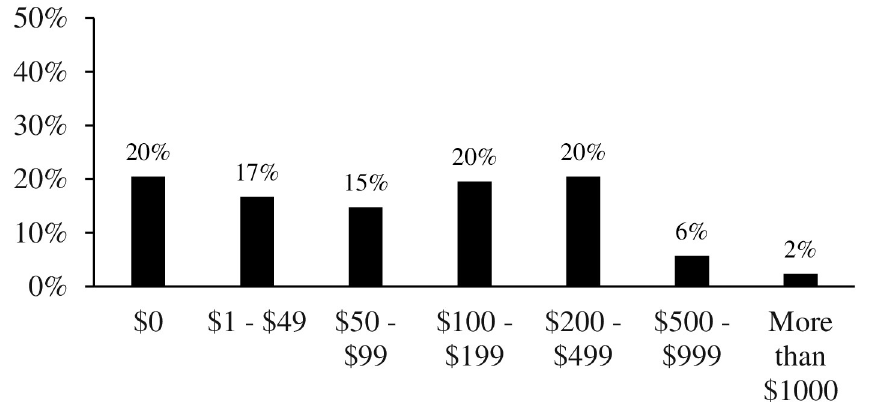
Fig 1. Response distribution for annual spend on digital